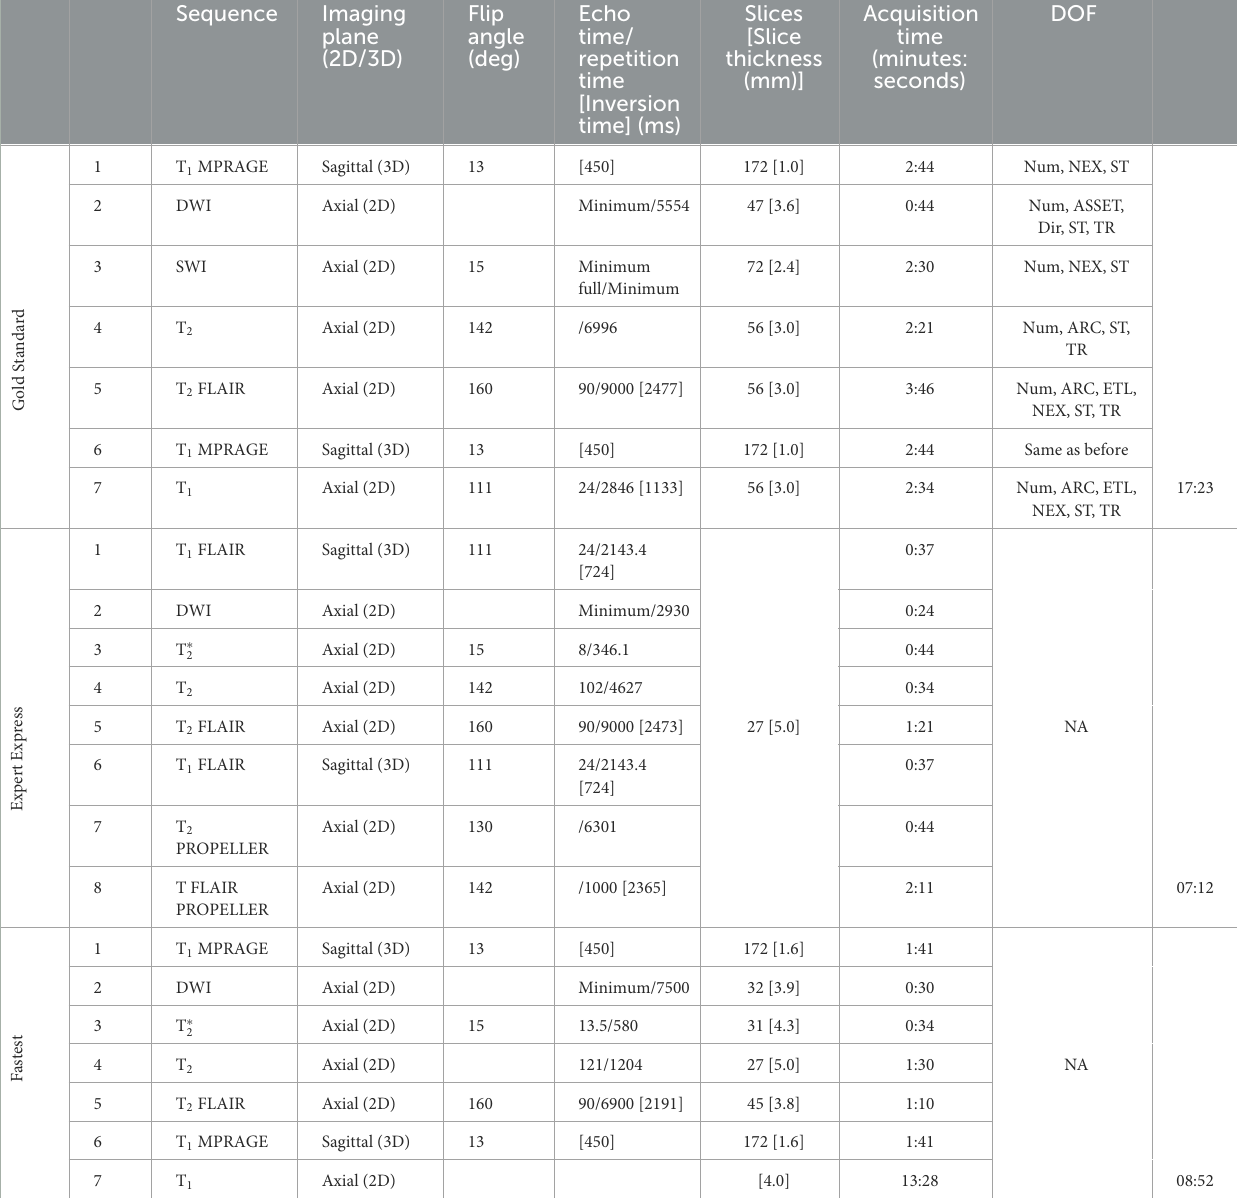
Each protocol’s acquisition duration is presented above the arrow-outs. The degrees of freedom (DOF) represent the parameters that were varied to modify the GS protocol without compromising the image contrast. Dir, diffusion directions; Num, number of slices; ARC/ASSET, acceleration options; ETL, echo train length; NEX, number of excitations; ST, slice thickness;